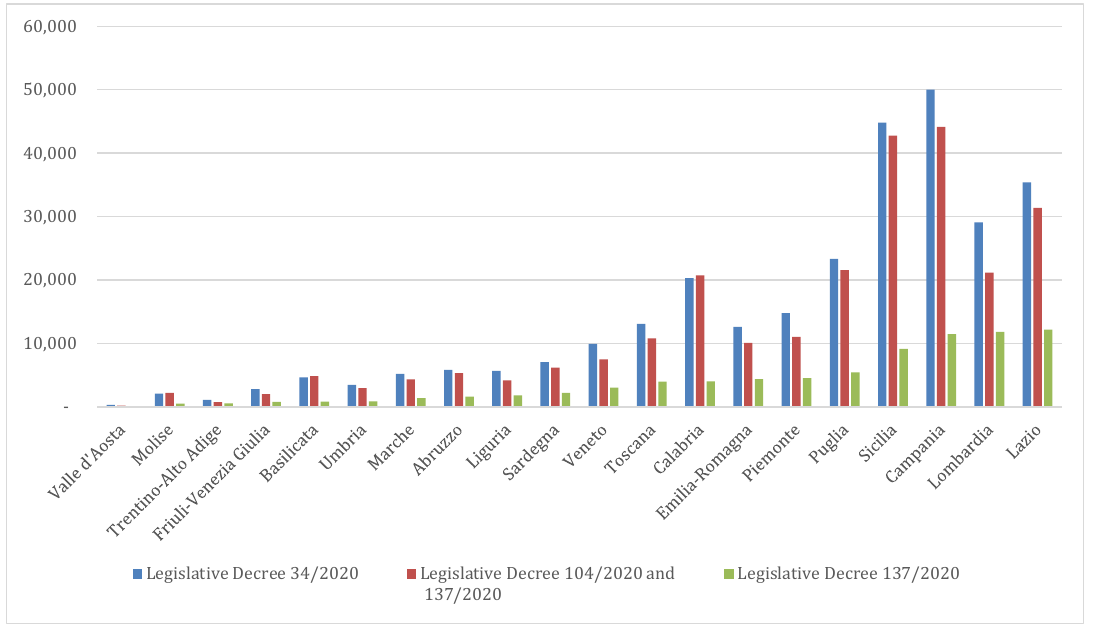
Figure 16. REM household recipients, by regions and Legislative Decree, 2020. Source: own elaboration on the INPS database.